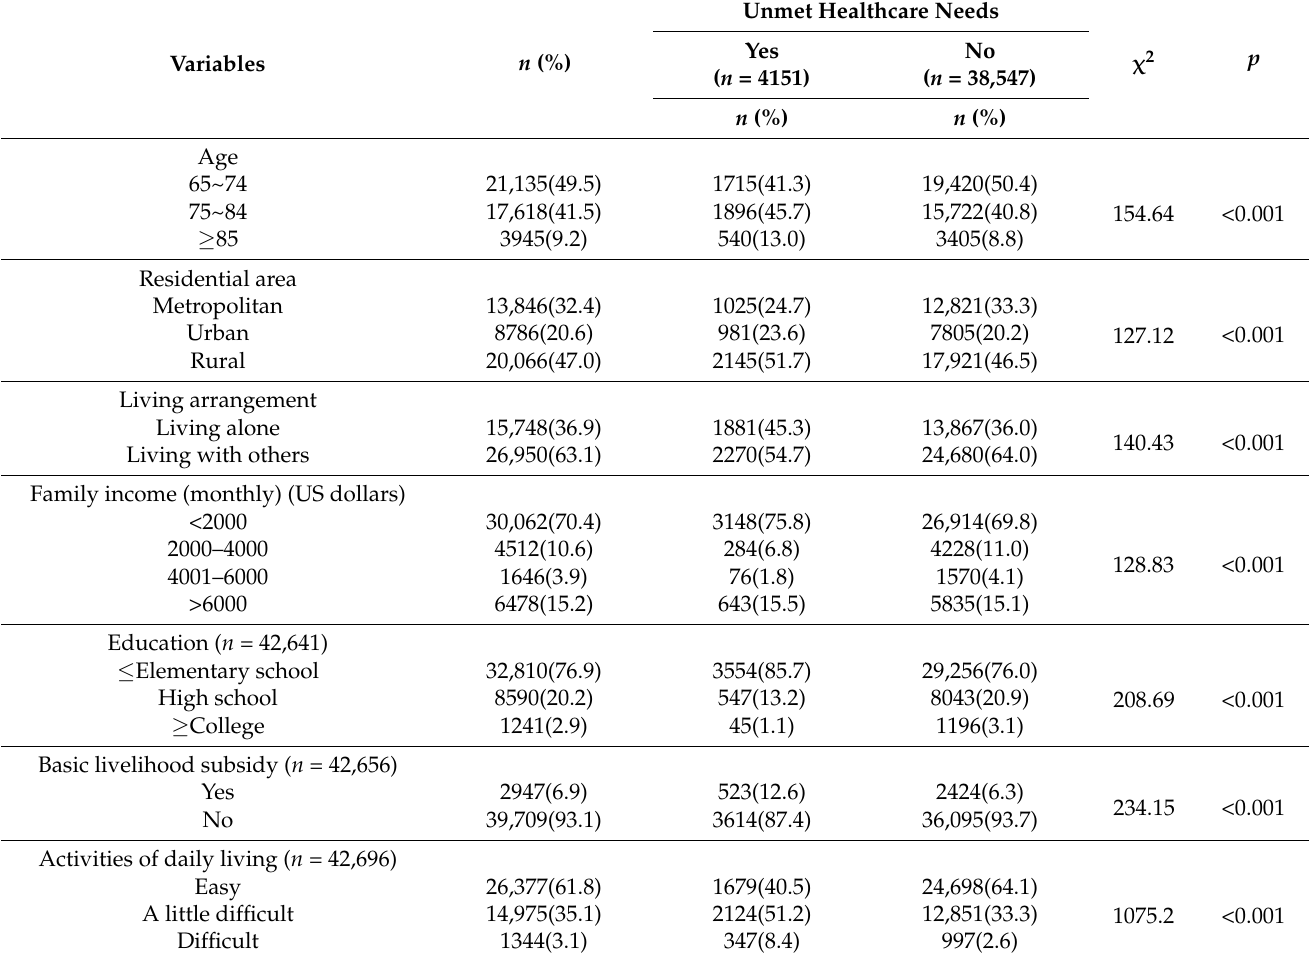
Table 1. Baseline characteristics by unmet healthcare